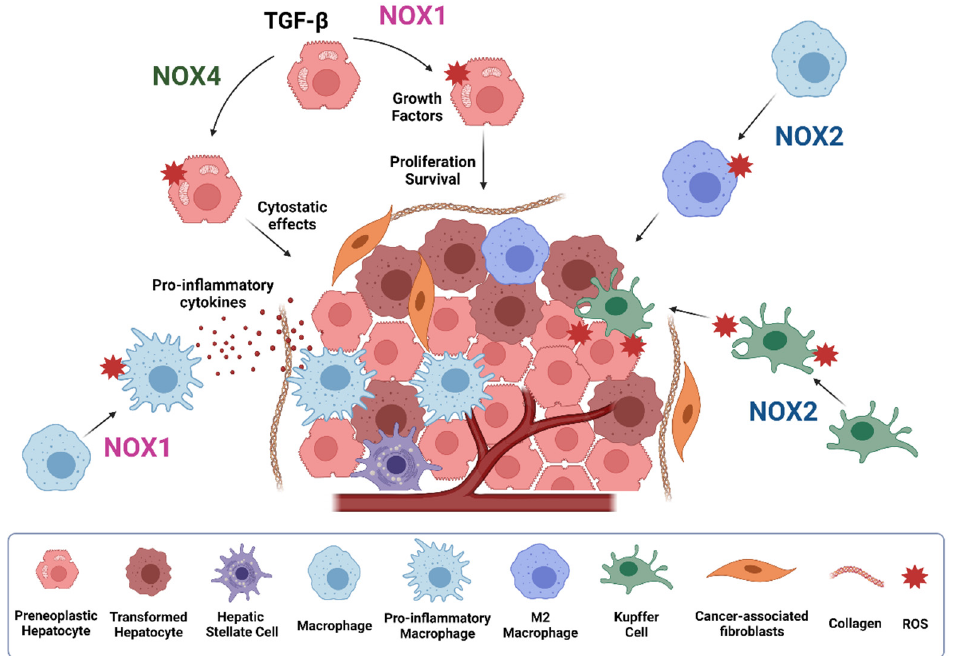
Figure 5. Role of NOXs during HCC development. NOX1 and NOX4 play opposite roles in hepatocytes and liver tumor cells. While NOX4 induces cytostasis, NOX1 mediates proliferative and survival signals. NOX1 also mediates activation of macrophages to pro-inflammatory macrophages, promoting inflammatory cytokines secretion. NOX2 promotes M2 macrophage polarization and superoxide production by kupffer cells, contributing to the promotion of HCC. Figure was created with BioRender.com (accessed on 20 July 2021).